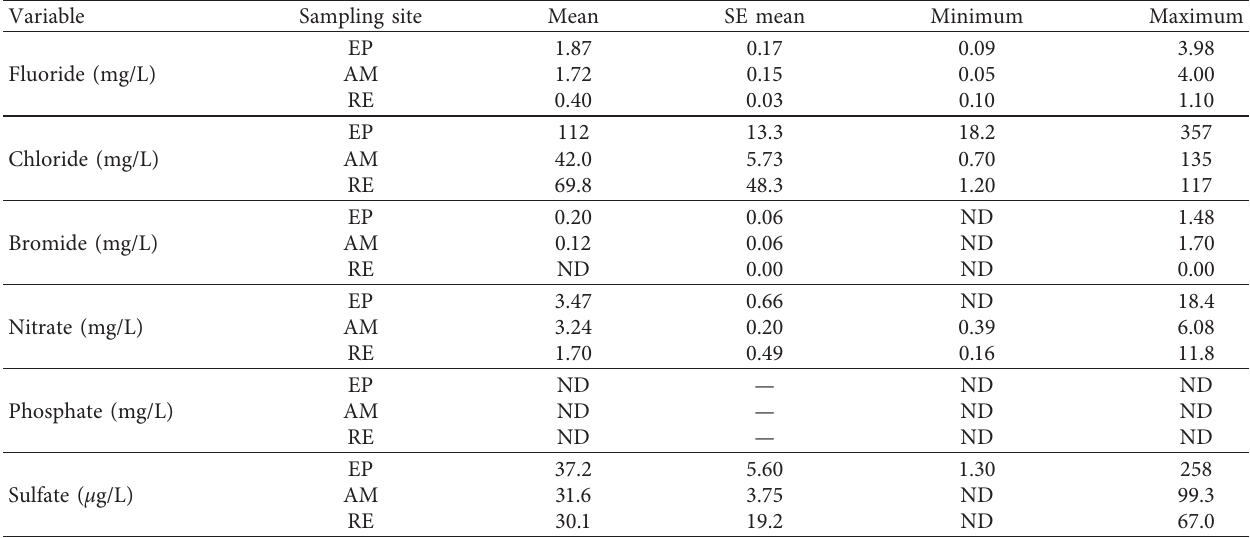
Figure 1: Graphical representation of lead, cadmium, arsenic concentrations, and fluoride content in collected drinking water samples in both CKDu hotspots: Eppawala GND and Ambagasewewa GND. Table 2: Statistical evaluation of counterions of the drinking water sources in the selected CKDu prevalence areas: Eppawala (EP) and Ambagaswewa (AM) GNDs and the reference